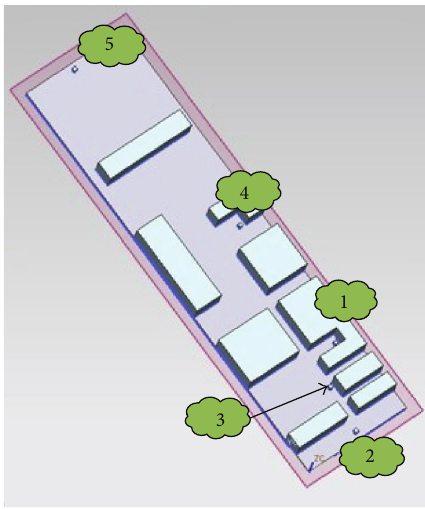
Figure 1: 3D model of Shanghai University